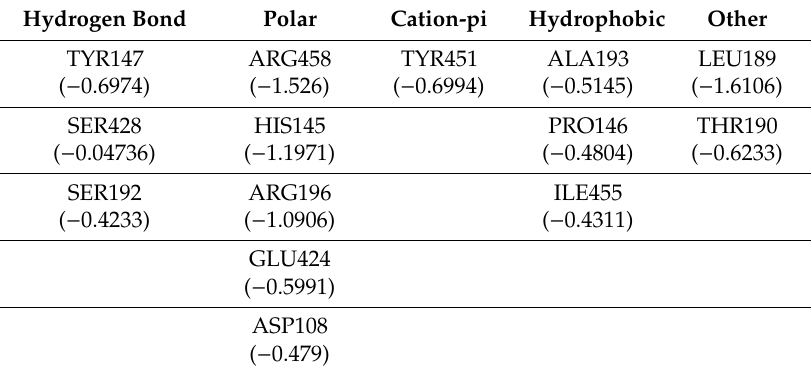
Figure 3. ( a ) Binding pocket for luminespib in BSA; ( b ) amino acid residues of BSA that interact with luminespib through hydrogen bond interactions. It also shows the interaction bonding distance for the hydrogen bonds when BSA protein interacts with luminespib. Table 2. The amino acid residues of BSA (PDI: 3V03) that interacts with luminespib to form a stable protein-ligand complex.